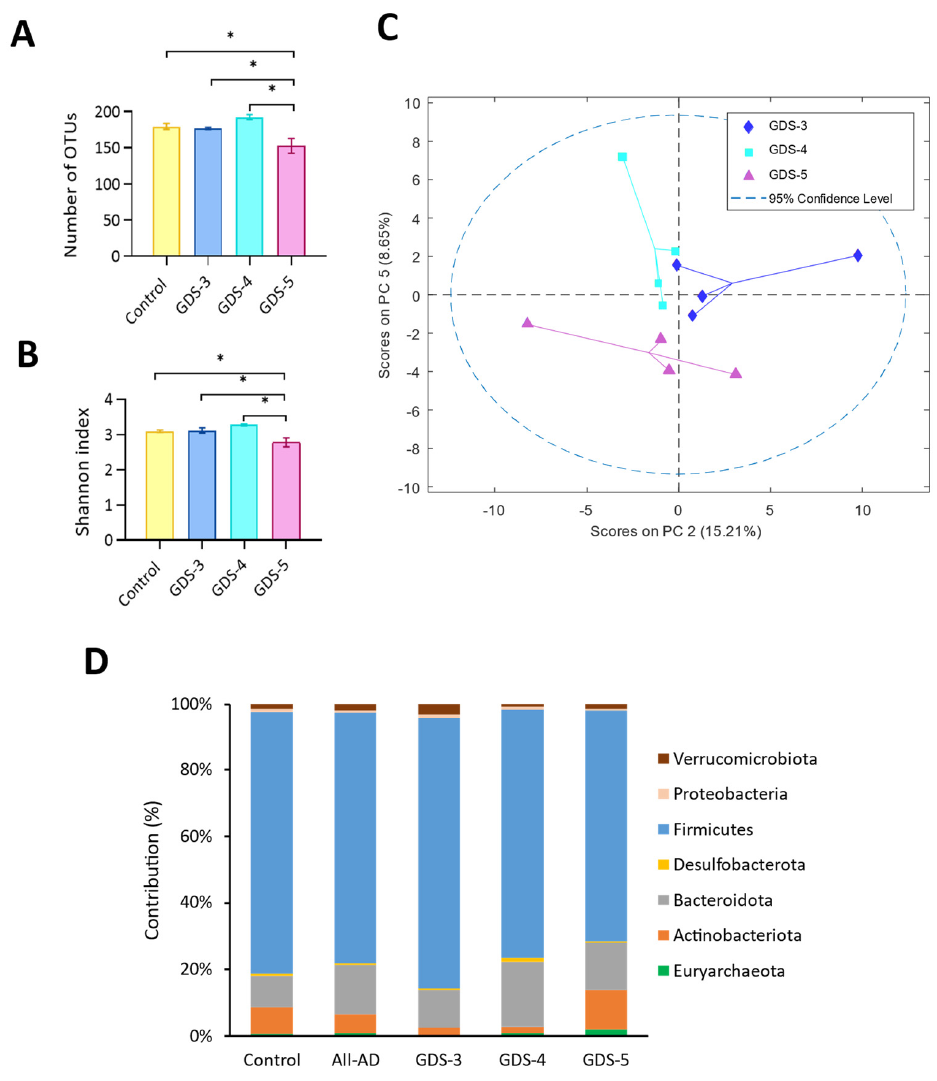
Figure 7. Gut microbiota composition in the feces from the control subjects and the Alzheimer’s disease (AD) patients classified in the stages GDS-3, GDS-4 and GDS-5. ( A ) The richness calculated as the number of the unique operational taxonomic units (OTUs) present in a subject. ( B ) The alpha diversity calculated using the Shannon index at the genus level. The ANOVA shows the significant differences in AD at GDS-5 ( p < 0.05). The data are the means ± the SEM; Tukey’s test: * p < 0.05. ( C ) The principal component analysis (PCA) of the gut microbiota. The scores of the PCA model were carried out with the area of the relative abundance at the genus level from the AD patients at GDS-3, GDS-4 and GDS-5. ( D ) The relative contribution of the bacterial taxa at the phylum level in the control subjects and the AD patients at GDS-3, GDS-4 and GDS-5; (n = 10, control subjects; n = 12, AD patients; 4 per stage).